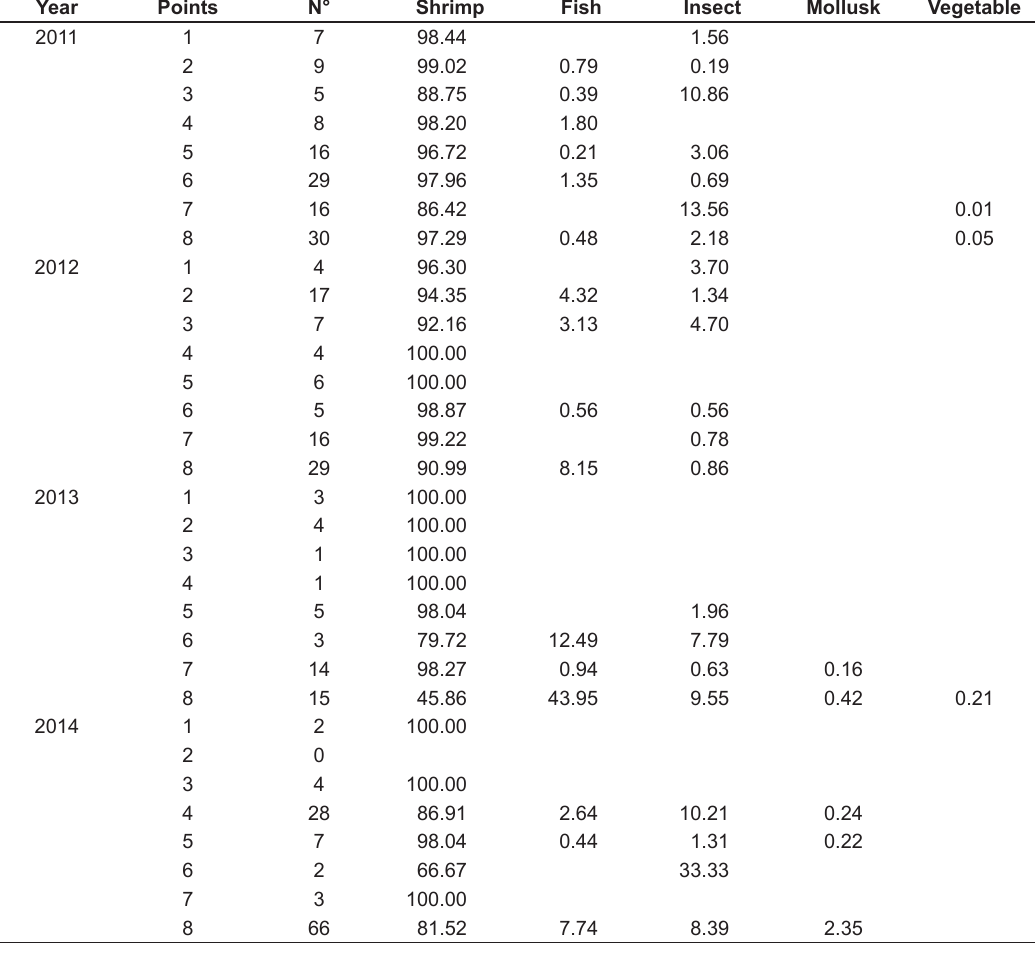
Table 2. Feeding Index (IAi), point and year of sample, of Plagioscion squamosissimus , collected quarterly, between February 2011 and November 2014, at the Santa Cruz Reservoir, Rio Grande do Norte. N° - number of stomachs analyzed.